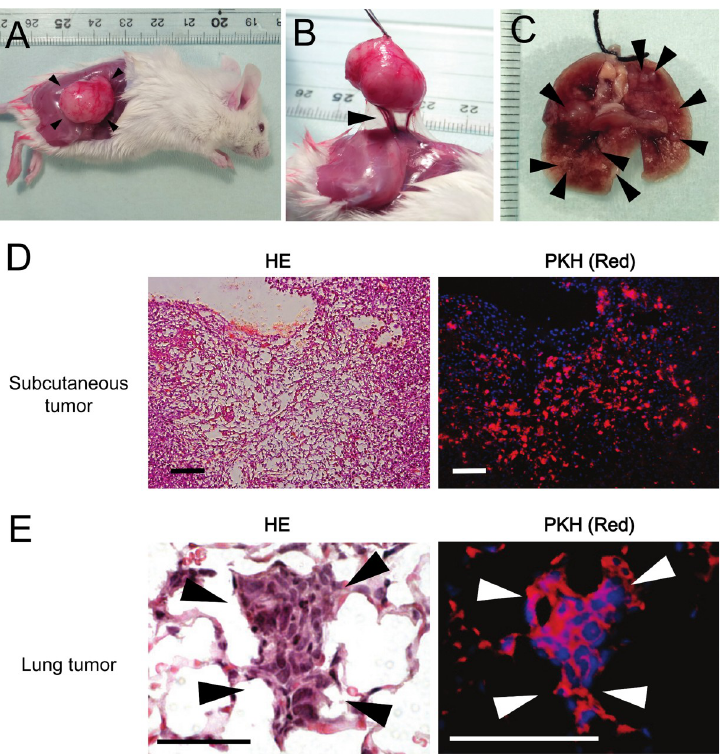
Fig 4. Tumorigenicity of PIS-1 cells. PIS-1 cells (2 × 10 6 ) were injected subcutaneously or intravenously into a male C.B-17/lcr-scid/scidJcl (SCID) mouse. (A) Subcutaneous enlarged tumor 28 days after subcutaneous injection (arrow head). Skin around the tumor was removed. (B) Neo tumor vessels were connected with the subcutaneous tumor and the back of the mouse (arrow head). (C) Multiple lung tumors 49 days after intravenous injection (arrow heads). (D) PIS-1 cells labeled by PKH-26 were present at the central area of a subcutaneous tumor. Scale bars, 100 μ m. (E) Lung tumors were composed of cells positive for PKH-26. Scale bars, 50 μ m. Nuclei stained with DAPI are represented by